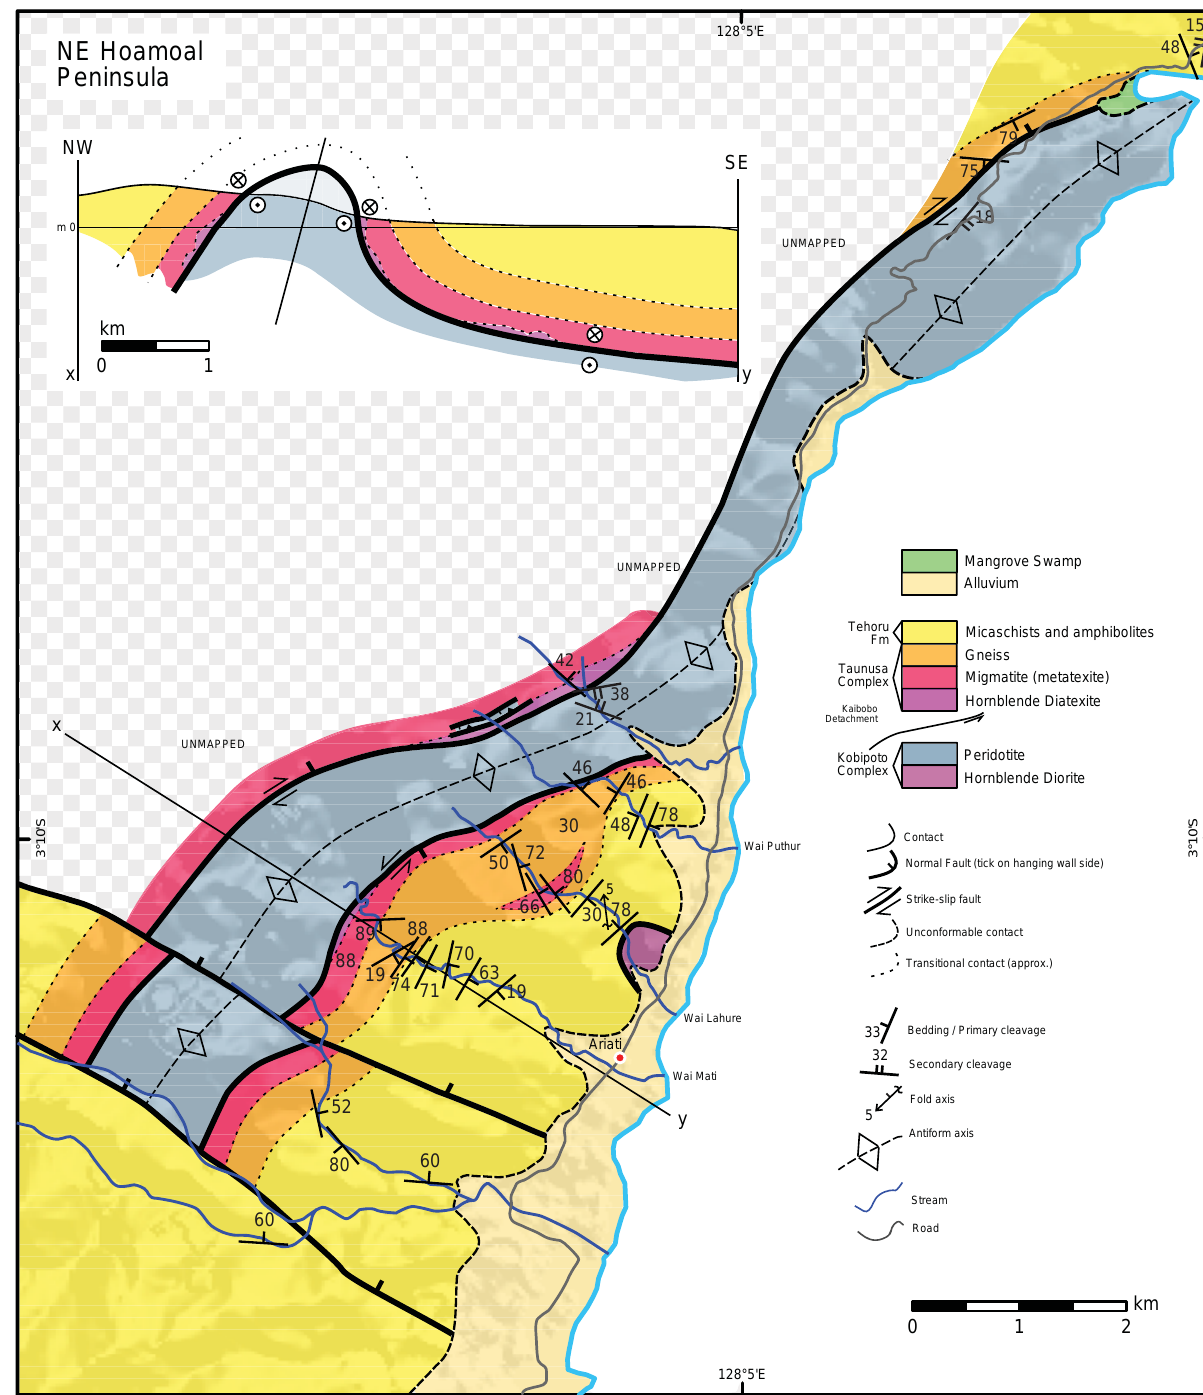
Fig. 9. Geological map of the NW Hoamoal Peninsula. Cross section Y–Y 0 (top-left) is drawn across profile Y–Y 0 indicated on the map and has no vertical exaggeration. The chequered area has not been mapped. See Fig. 3 for map location.